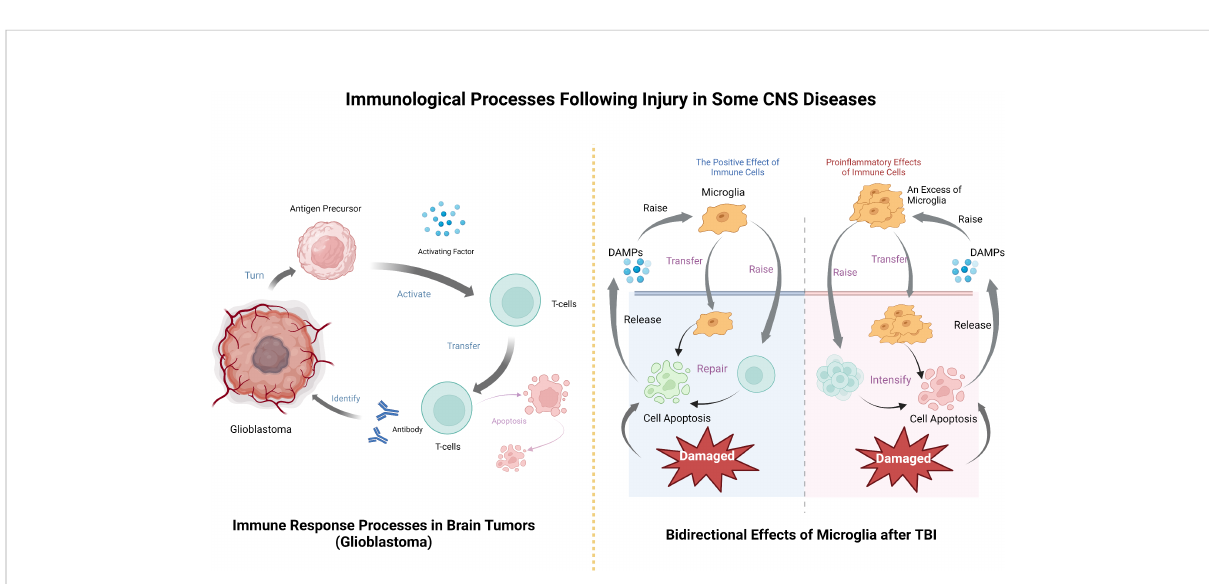
FIGURE 2 The processes by which immune cells exert their effects after CNS tumors and TBI, including their bidirectional effects on the disease.